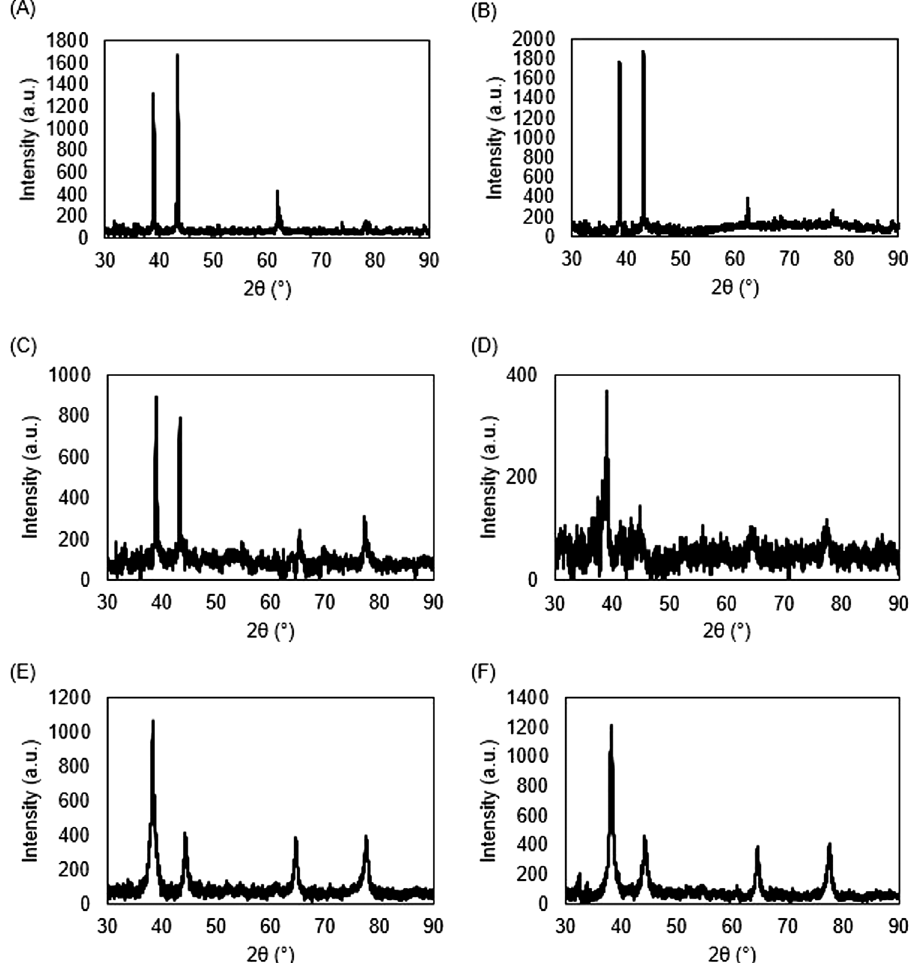
Figure 7: Powder XRD pattern of silver nanoparticles (AgNPs) obtained from AgNPs colloidal solution using LHE at the different concentrations: (a) 0.003 wt%, (b) 0.01 wt%, (c) 0.05 wt%, (d) 0.1 wt%, (e) 0.5 wt%, and (f) 1.0 wt%, respectively.